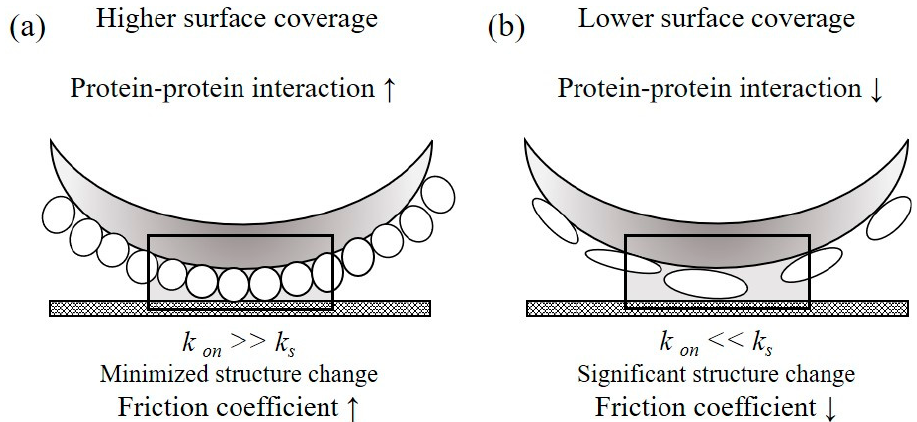
Figure 4. Influence of protein–protein effects on the surface friction coefficient values. A comparison of contact lens surfaces with different surface protein coverages causes separate boundary lubrication, resulting in schematic diagrams with varying friction coefficients. Under the minimized structure change ( a ), the high shear strength layer was observed at the interface. In the case of lower surface coverage ( b ), there is the opposite result. The adsorption rate of interacting the protein with the surface was represented by k on , and the unfolding rate of adsorbed protein on the adsorbent surface was expressed as k s .